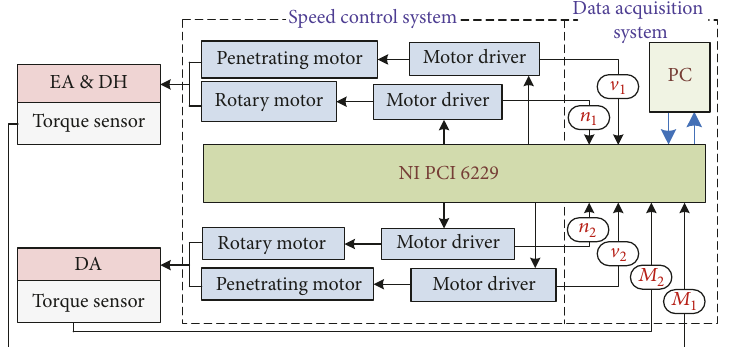
Figure 9: Speed control and data acquisition